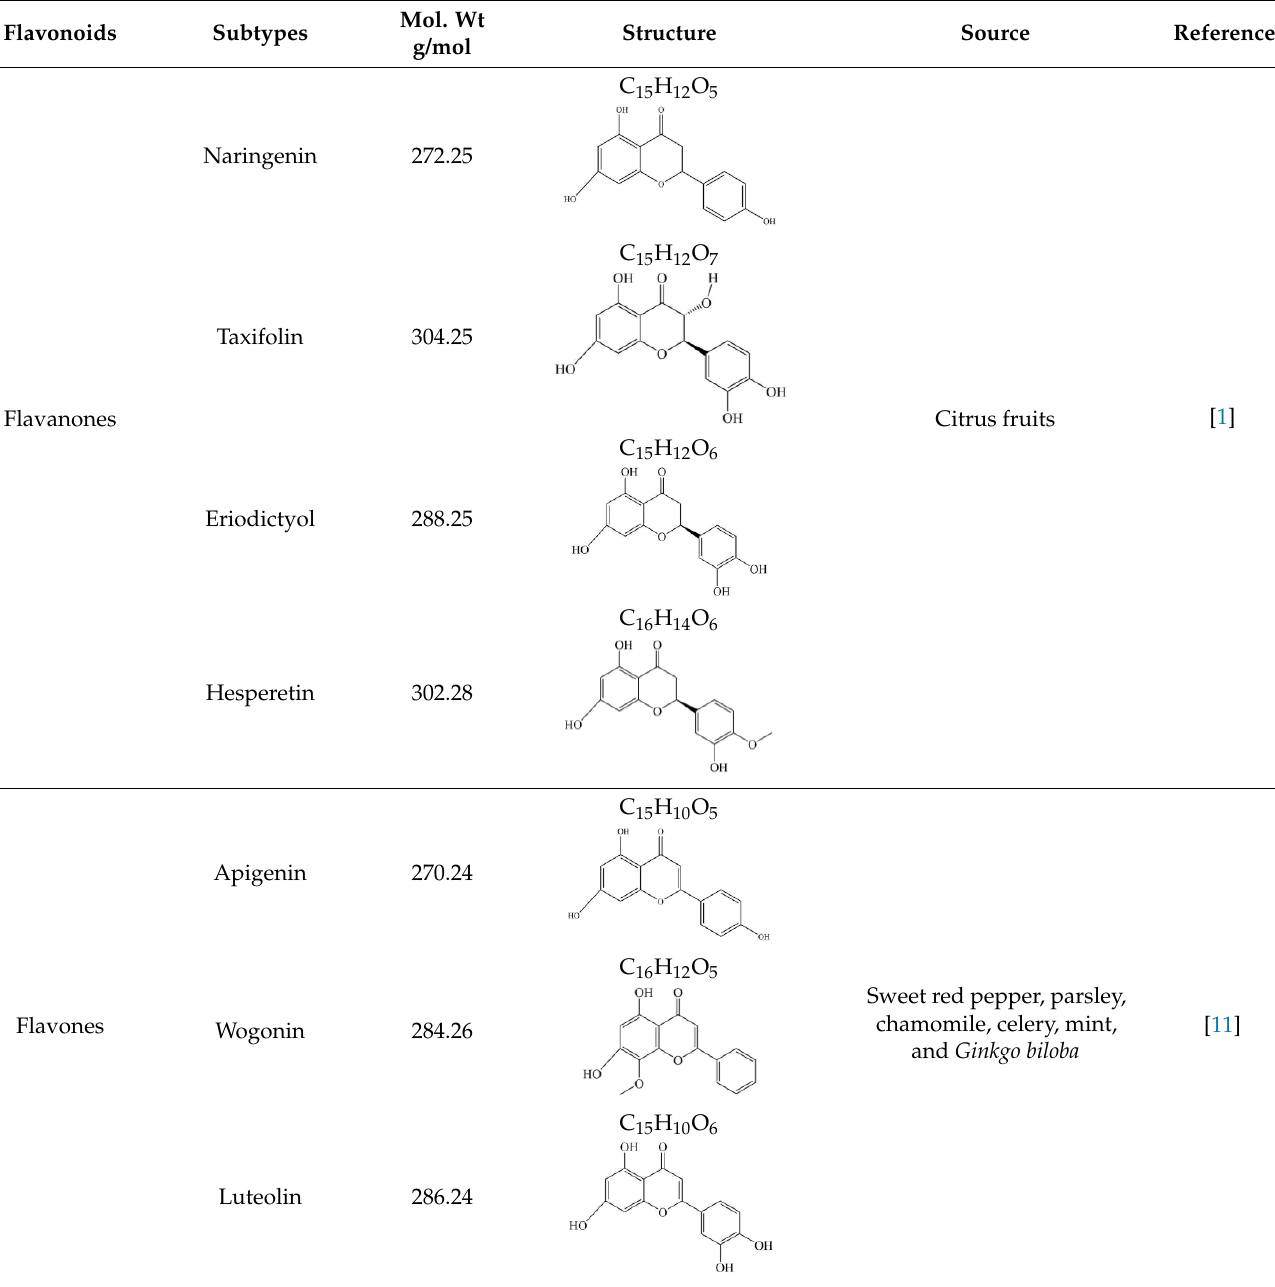
Table 1. Different classes of flavonoids, their subtypes, structure, and sources of their isolation. Mol. Wt Flavonoids